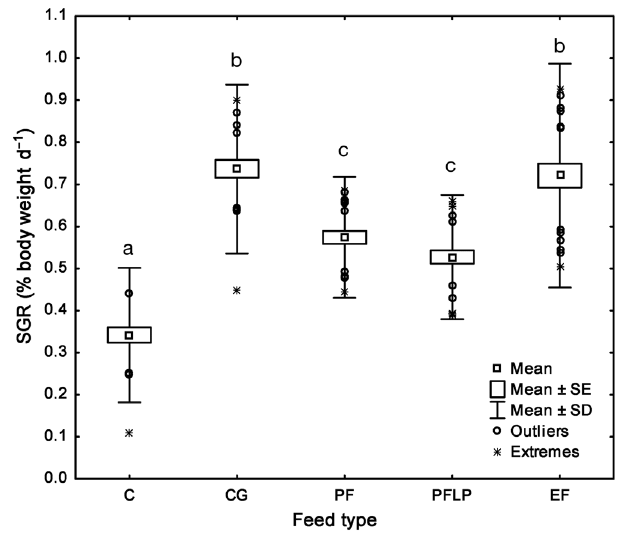
Fig. 1. Specific growth rate (SGR) of common carp Cyprinus carpio (means and SD, n = 22) calculated for different supple- mentary feeding treatments after 112 d. Treatments with dif- ferent letters are significantly different (p < 0.05) according to Tukey’s post hoc test. C: control without supplementary feed; CG: cereal grains; PF: pelleted feed; PFLP: pelleted feed with